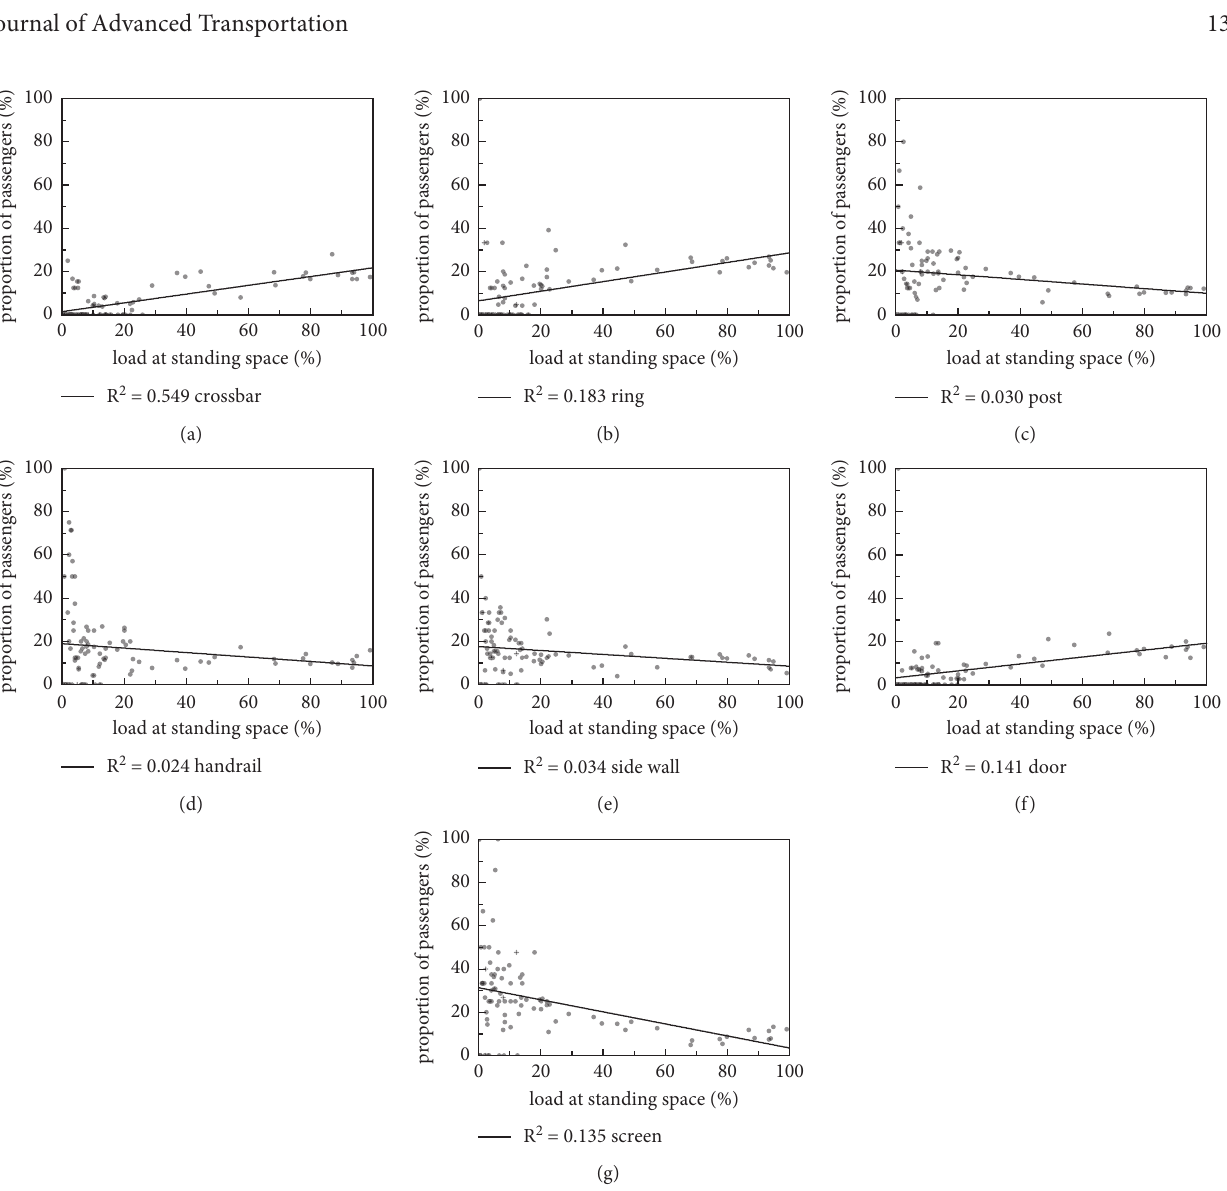
Figure 10: Changes in the proportion of passengers using different auxiliary standing